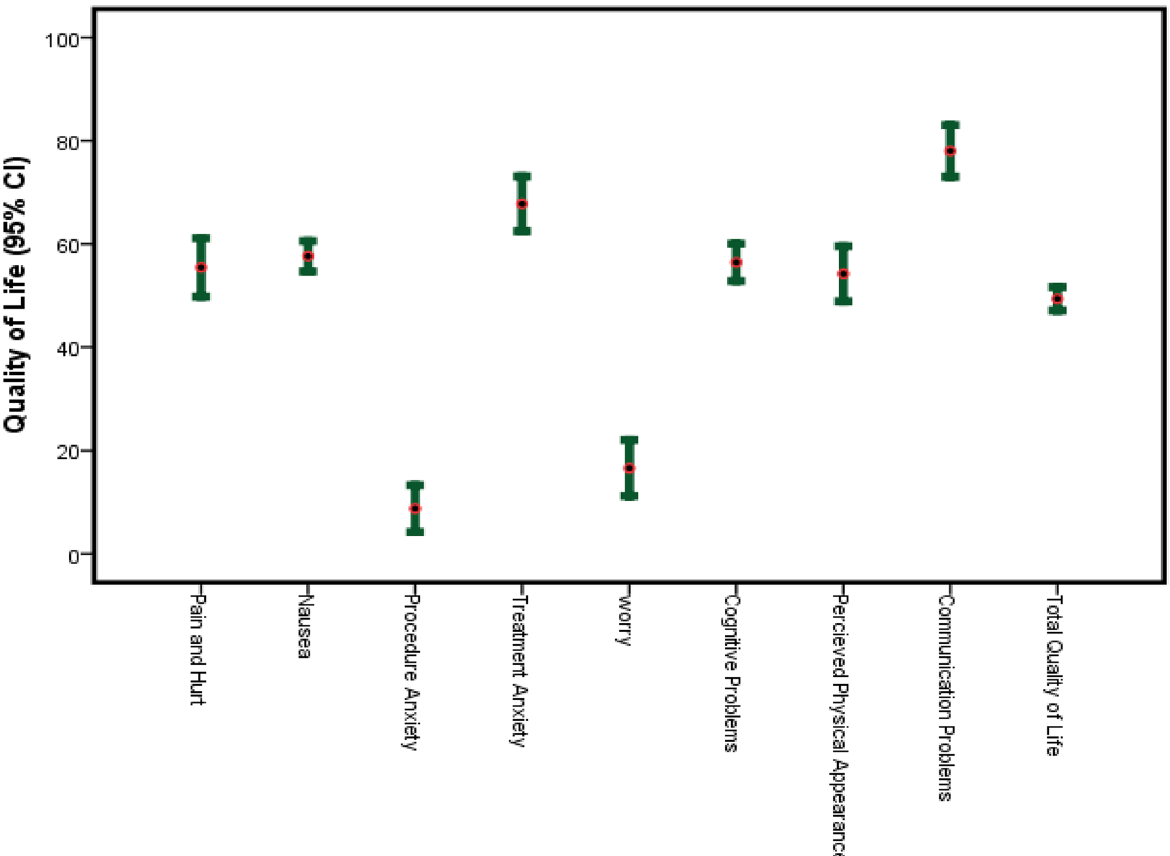
Fig. 1 95% confidence interval for the overall quality-of-life scores and its domains in